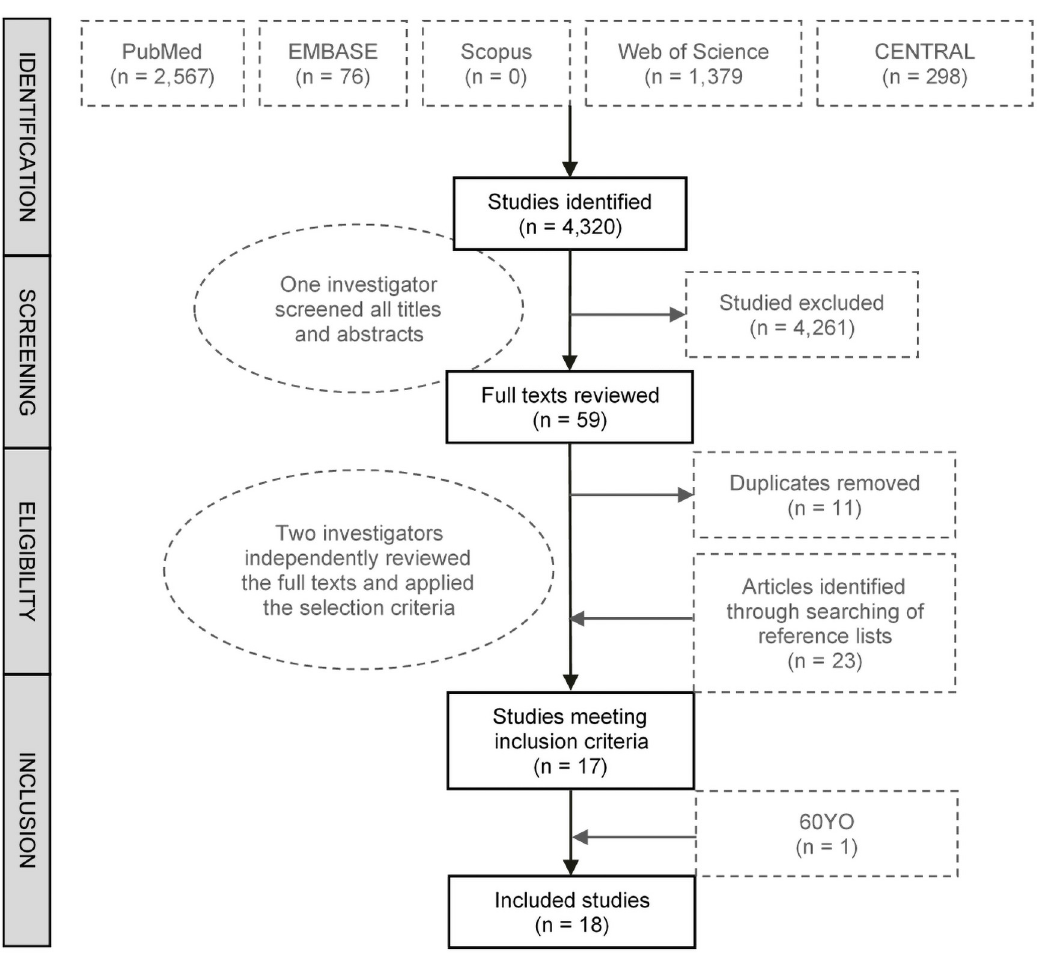
Fig 3. Flow chart of systematic review and selection